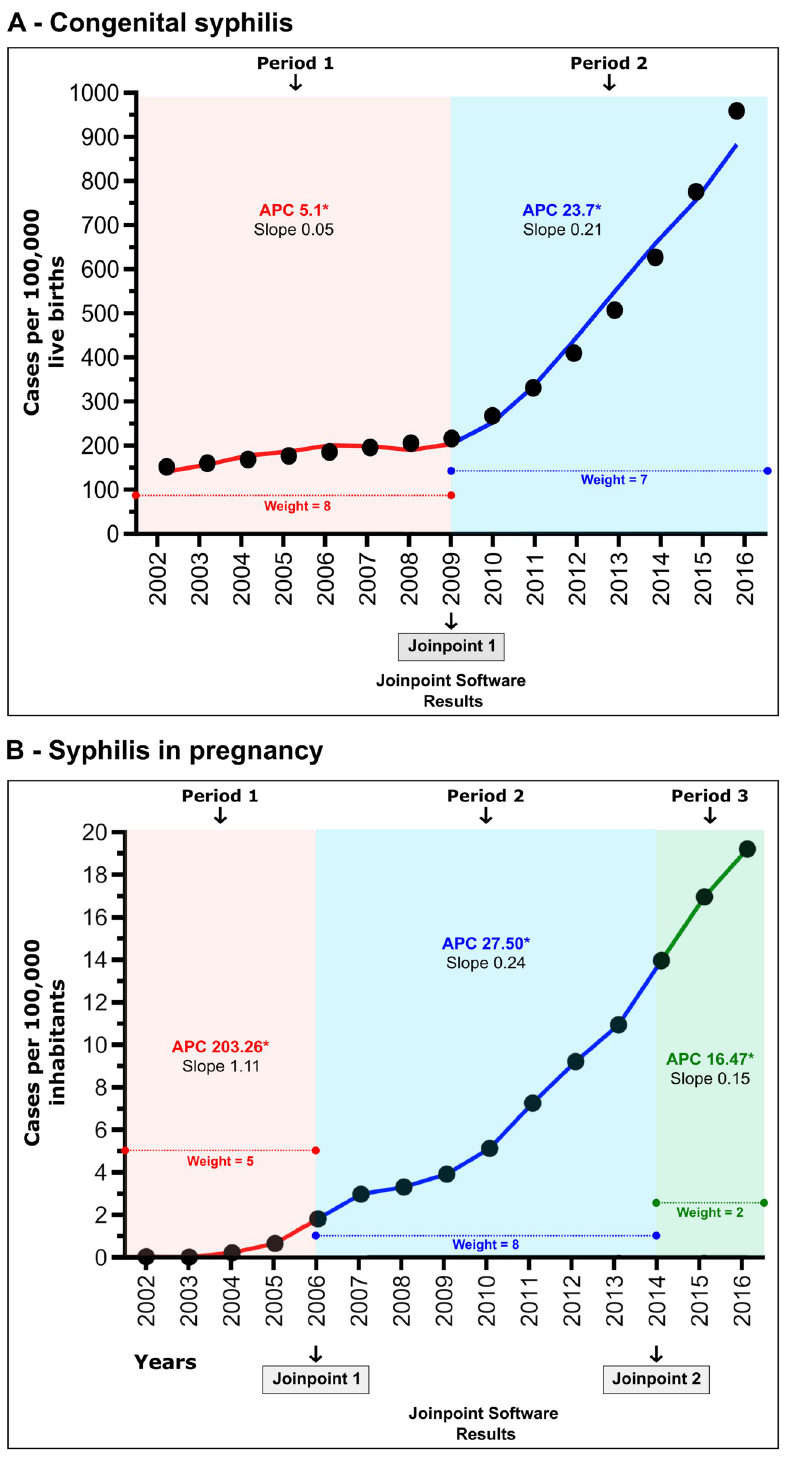
Fig 2. Global incidence in Brazil per 100,000 inhabitants of CS (A) and SiP (B) according to SINAN. Joinpoint regression analysis using APC (Annual Percentage Change) calculations identified three distinct periods for each form of